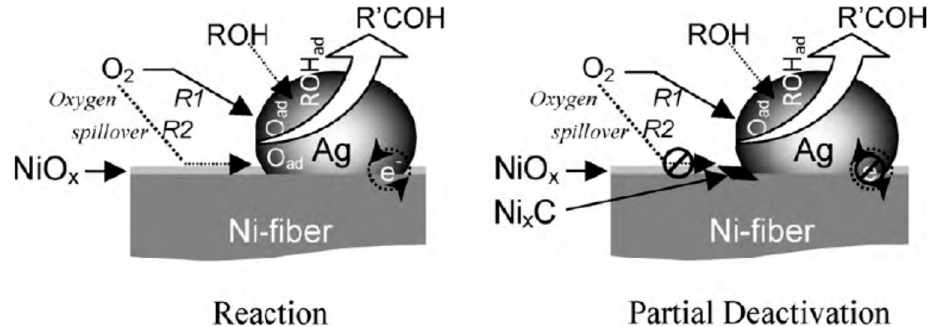
Figure 6. Possible reaction and partial deactivation schemes for the gas-phase selective oxidation of benzyl alcohol over the Ni-microfibrous-structure supported silver catalysts. Note: R1, direct O 2 activation route; R 2 , NiO x -participating O 2 spillover route. Reprinted with permission from reference [73]. Copyright 2010 Elsevier.